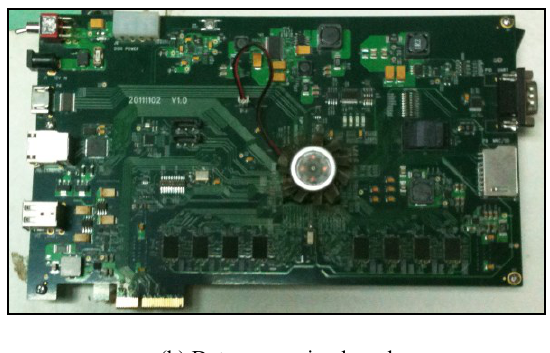
Figure 5. Data processing board based on ARM+DSP